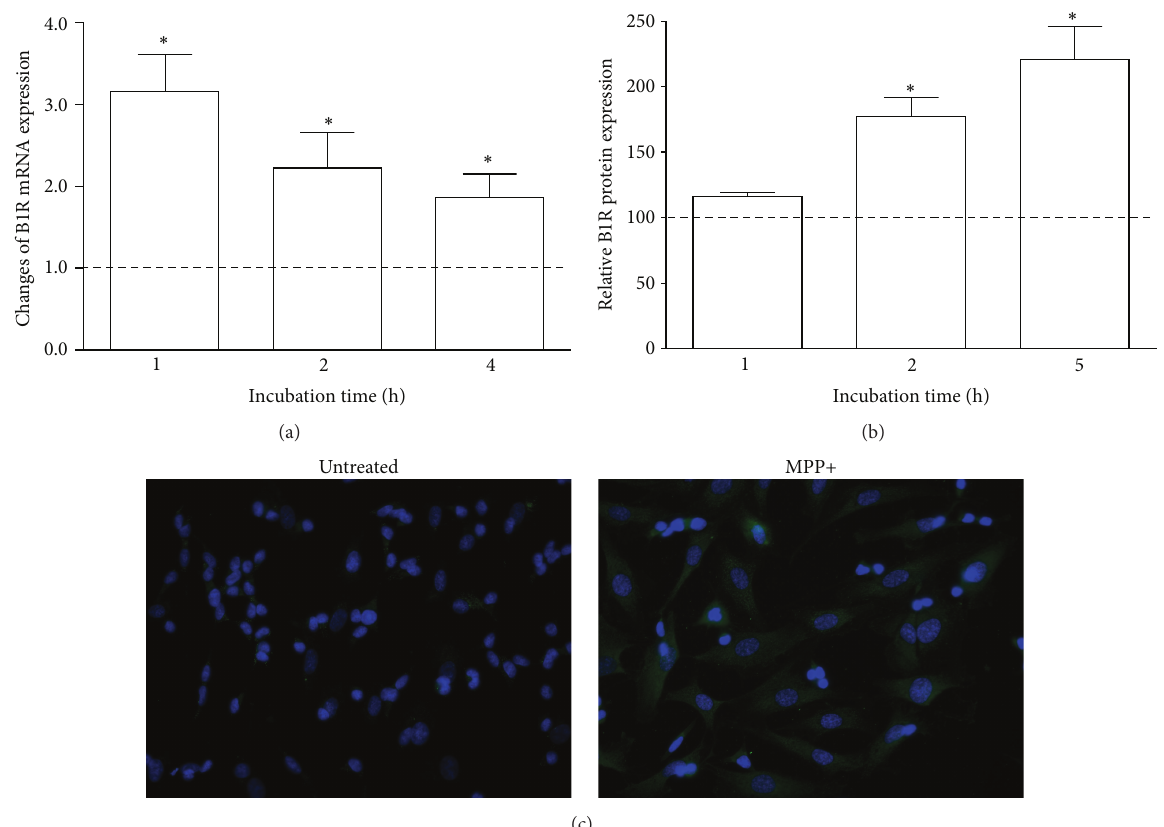
Figure 6: The effect of MPP+ on B1R expression in differentiated SK-N-SH cells. Confluent cells were incubated with MPP+ at different time intervals. (a) The changes of B1R mRNA expression after incubation at different time intervals were analyzed by Real-Time PCR and are presented as relative mean values in comparison to untreated cells, assumed to possess value equal to 1 (dashed line). The expression of B1R protein was analyzed by immunocytochemistry with specific antibodies and the quantification of fluorescence signal was performed as described in Materials and Methods (b). The results are shown as mean ± SD of the changes in comparison to untreated cells, assumed to possess 100% expression (dashed line). (c) The photographs show B1R expression on differentiated SK-N-SH cells without or after 5-hour incubation with MPP+. ∗ 𝑃 < 0.05 versus untreated